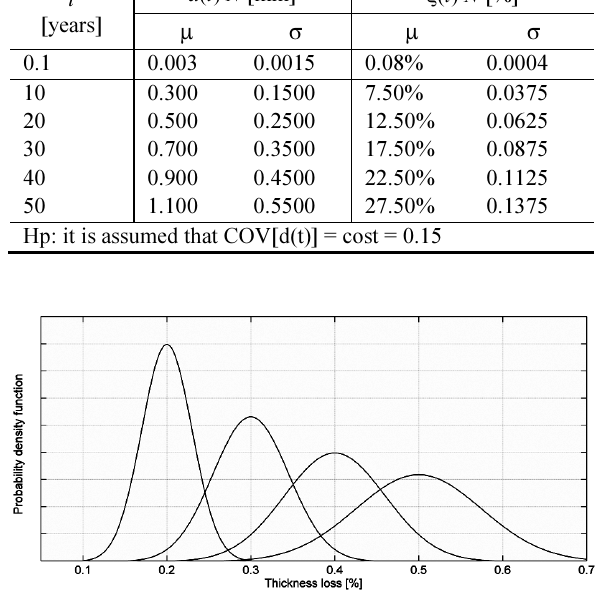
Fig. 6. The probability density function of the dimensionless corrosion damage ξ ( t ) as a function of time t